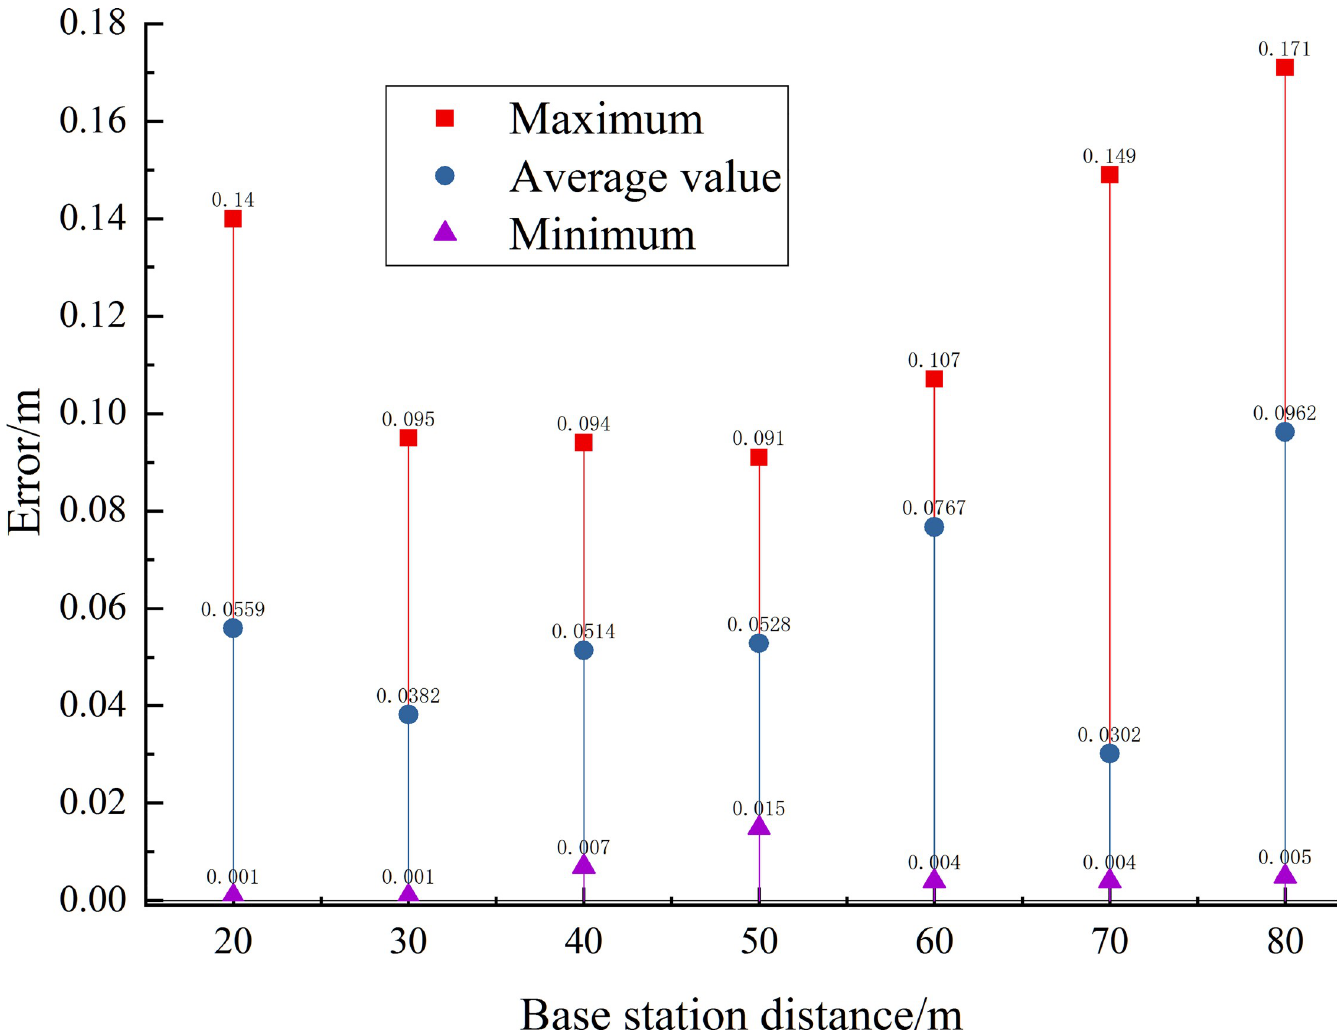
Fig 17. Comparison of three errors separations of positioning base stations ranging 20~80 m.